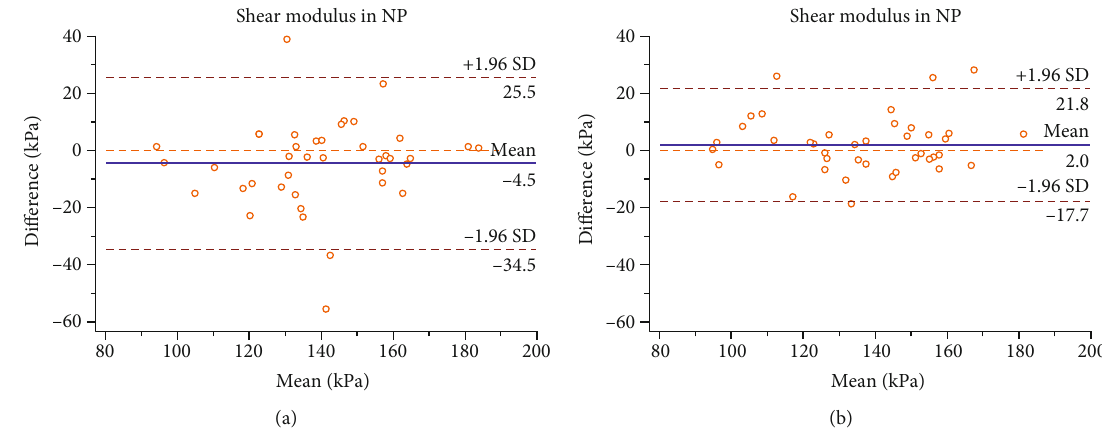
Figure 2: Bland-Altman plots of intra- and interoperator reliabilities for the shear modulus of the median nerve in the neutral posture (NP). Intraoperator reliability (a): the di ff erence in median nerve sti ff ness between day 1 and day 5 is plotted against mean median nerve sti ff ness (average of the 2 days for operator A) for each subject. Interoperator reliability (b): the di ff erence in median nerve sti ff ness between operator A and operator B is plotted against mean median nerve sti ff ness (average of the 2 operators) for each subject. The continuous lines represent the mean di ff erence, while the dotted lines show the 95% upper and lower limits of agreement.